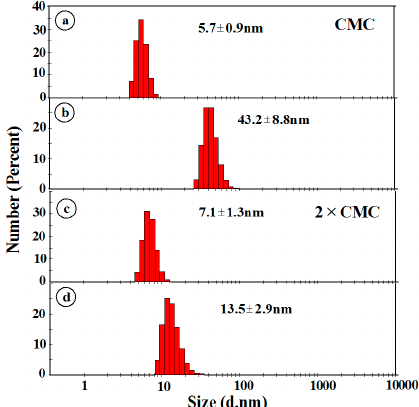
Figure 8. Size distribution histograms of the assemblies determined by DLS measurements carried out in PBS buffer solutions of ( a ) Triton X-100 CMC, ( b ) Triton X-100 CMC + FABT (0.07 mM), ( c ) Triton X-100 2× CMC, ( d ) Triton X-100 2× CMC + FABT (0.07 mM). The measurements were performed X-100 2 × CMC, ( d ) Triton X-100 2 × CMC + FABT (0.07 mM). The measurements were performed at the temperature of 22 °C.